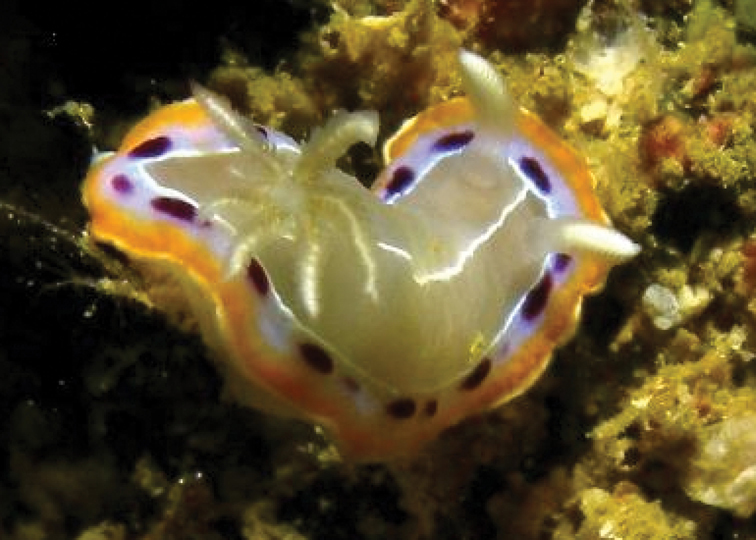
Chromodoris decora, Oman, photo: S Kahlbrock (no spcm).